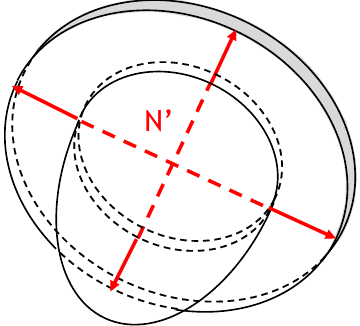
Figure 4. SCP, imaginary radial node.